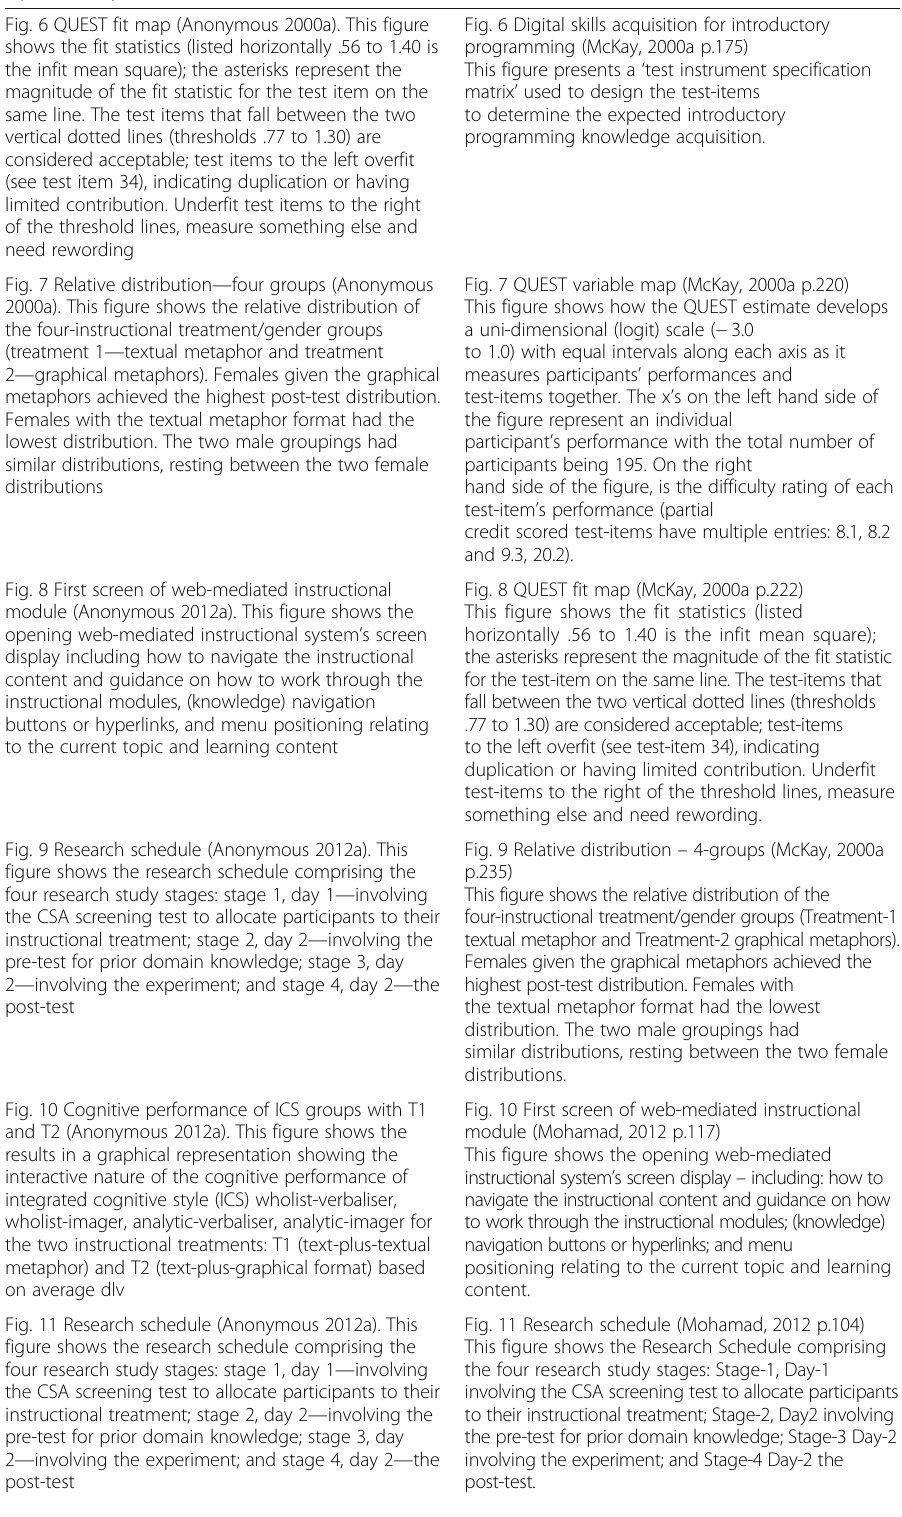
Fig. 6 Digital skills acquisition for introductory programming (McKay, 2000a p.175)